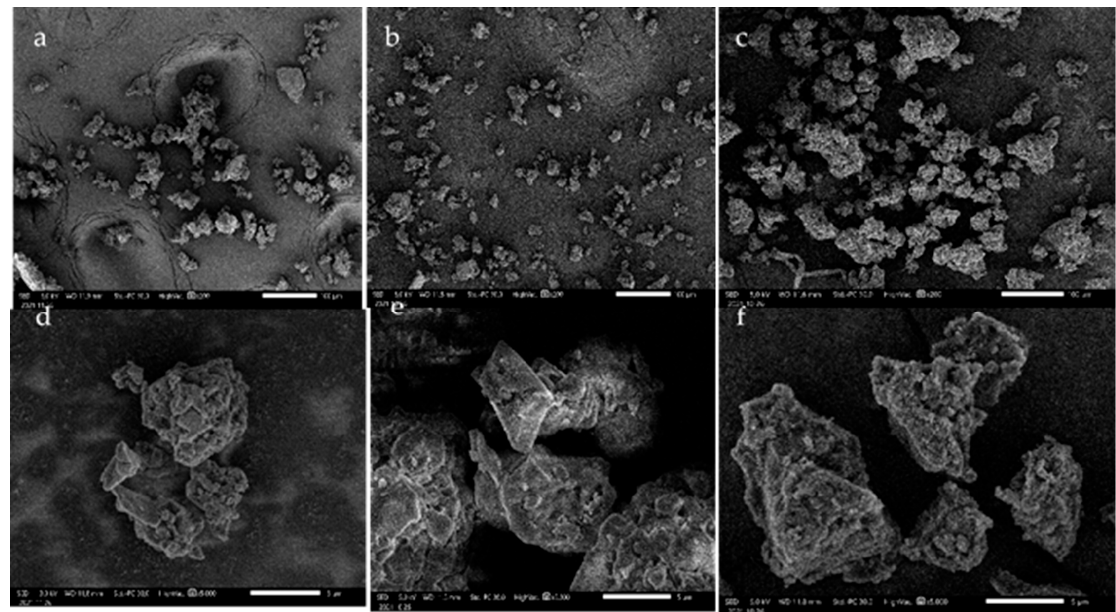
Figure 2. SEM micrographs show the morphological surface of reference lignin ( a ), single-step ( b ), fractionated-step ( c ) at 200× magnification and reference lignin ( d ), single-step ( e ), and fractionated-step ( f ), at 5000× magnification.